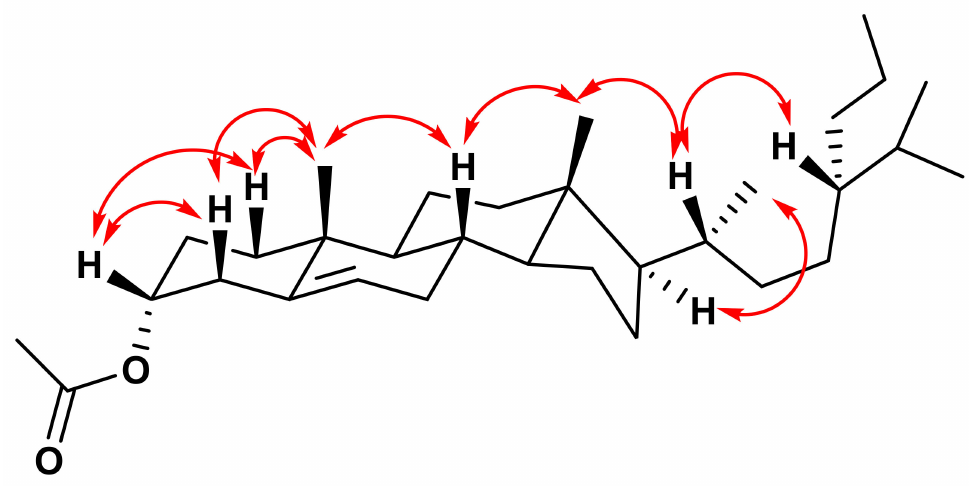
Figure 3. Selected NOESY correlations for 1